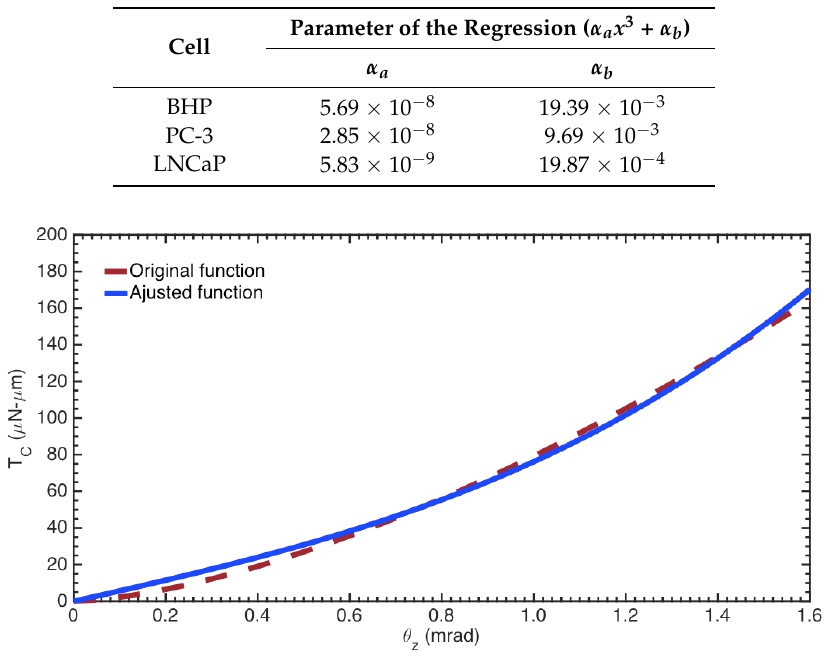
Table 5. Parameters to adjust the function T c for each cell type.